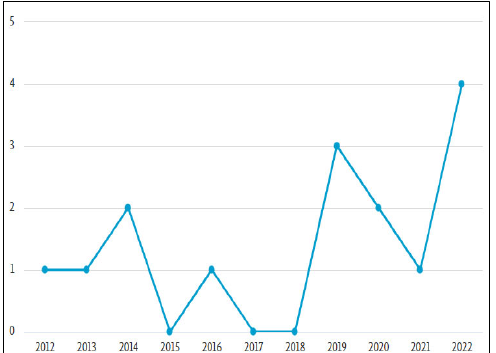
Fig. 3a. Biometric analysis of the words “Concrete”, “Pho- tocatalytic”, “Environmental” and “Work” Source: Scopus scientific review Source: Obtained from